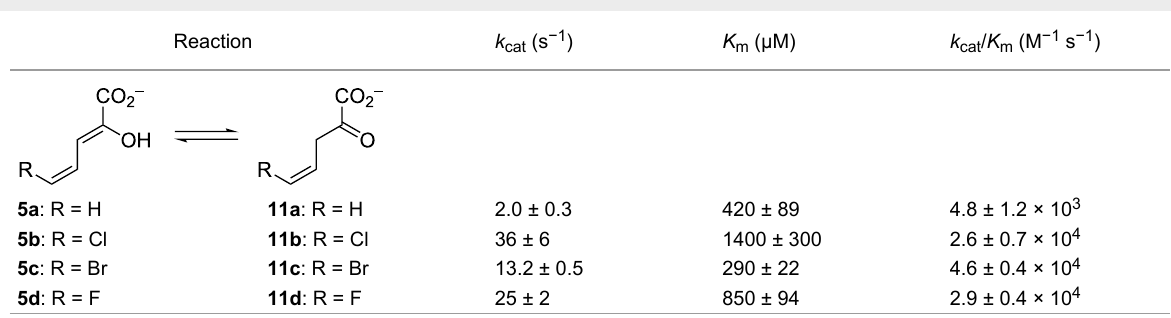
Table 5: Kinetic parameters for Lc 4-OT using 5a–d a